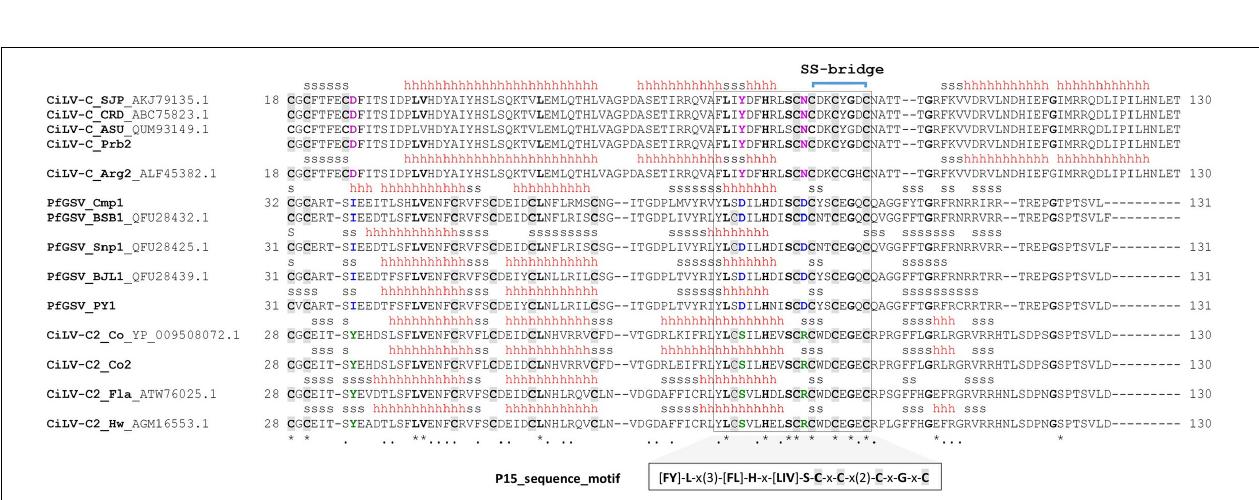
FIGURE 3 | Consensus sequence obtained from a multiple sequence alignment (MSA) of the cysteine-rich domain of the P15 protein family. MSA was built using ClustalO (Sievers and Higgins, 2014). The alignment was manually curated by analyzing gaps, conserved amino acid positions, and the predicted secondary structure. The non-aligning segments at the N-terminus of P15 proteins, presumably representing non-core regions, were removed. Conserved cysteine residues are highlighted by gray background and boldface letters. Secondary structure elements, as predicted by I-TASSER, are depicted on top. Helix and β -strand conformations are indicated by h and s, respectively. A conserved sequential motif {[FY]-L-x(3)-[FL]-H-x-[LIV]-S-C-x-C-x(2)-C-x-G-x-C} is displayed below the sequence alignment. Strictly conserved residues are in boldface and putative functional residues specific from each group are in magenta, blue, and green colors. The putative disulfide bridge between the cysteine residues (positions 85 and 92 in CiLV-C) is represented by a blue bracket. Asterisk and point symbols beneath the alignment indicate strictly conserved residues and conservative substitutions, respectively.